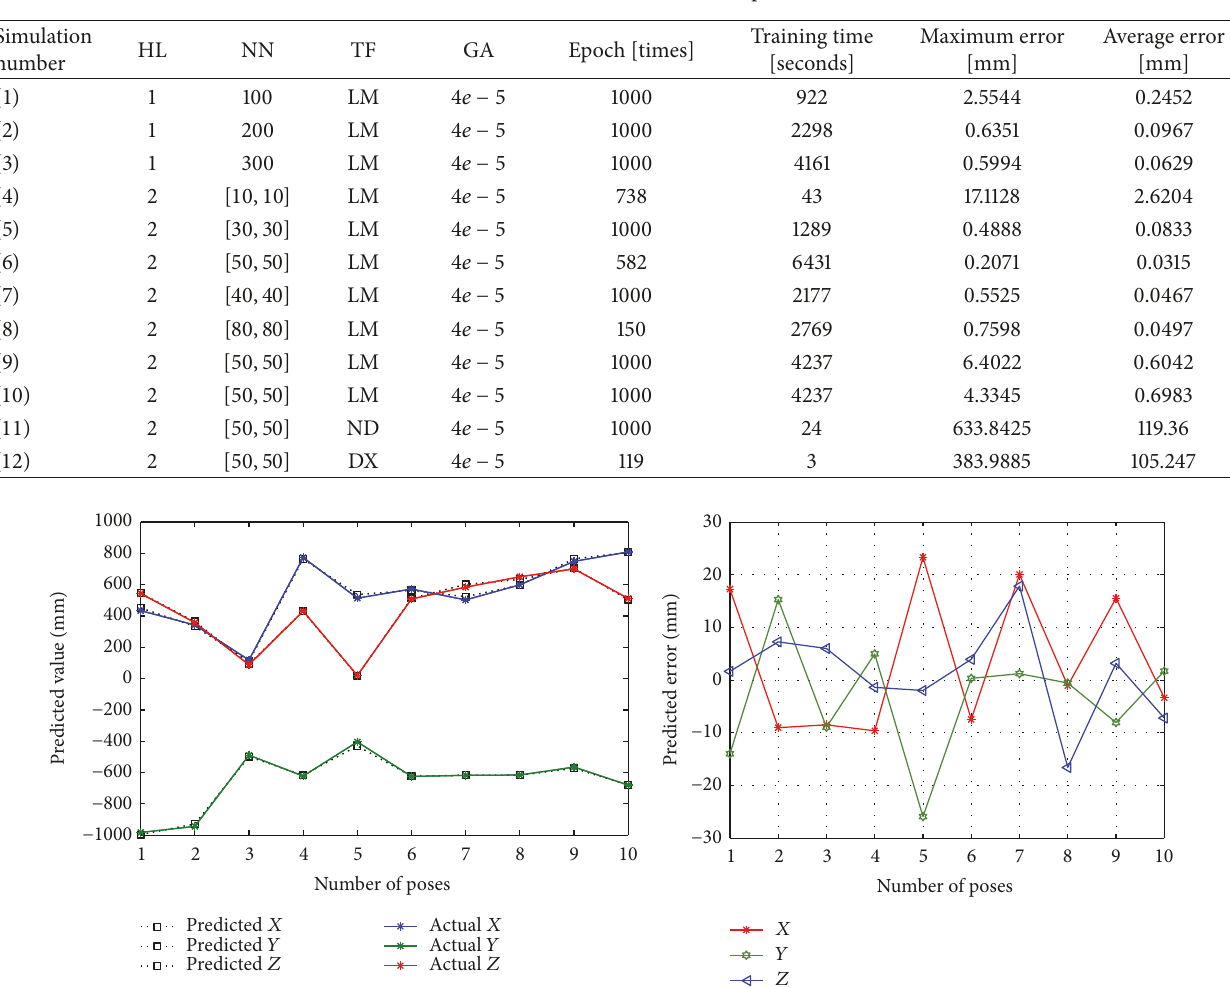
Table 3: Prediction simulation results for optimization.